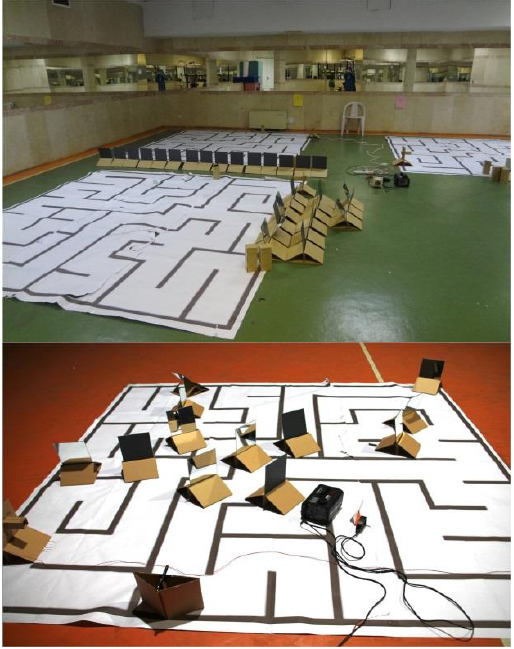
Figure 7 Game set and workshop set